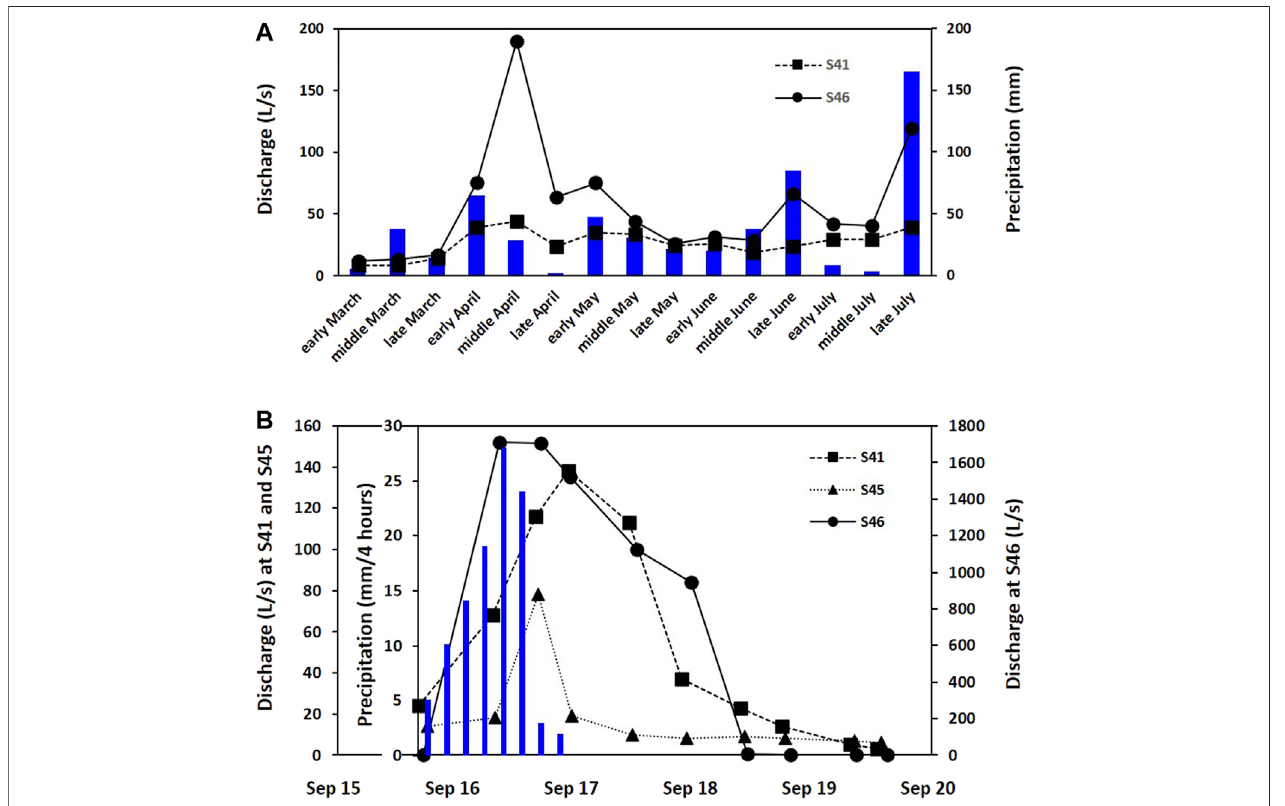
FIGURE 2 | Hydrological responses of three Type Ⅱ springs from March to July in 1999 (A) and during the typhoon event named Saomai in 2000 (B) . The blue bar indicates precipitation.